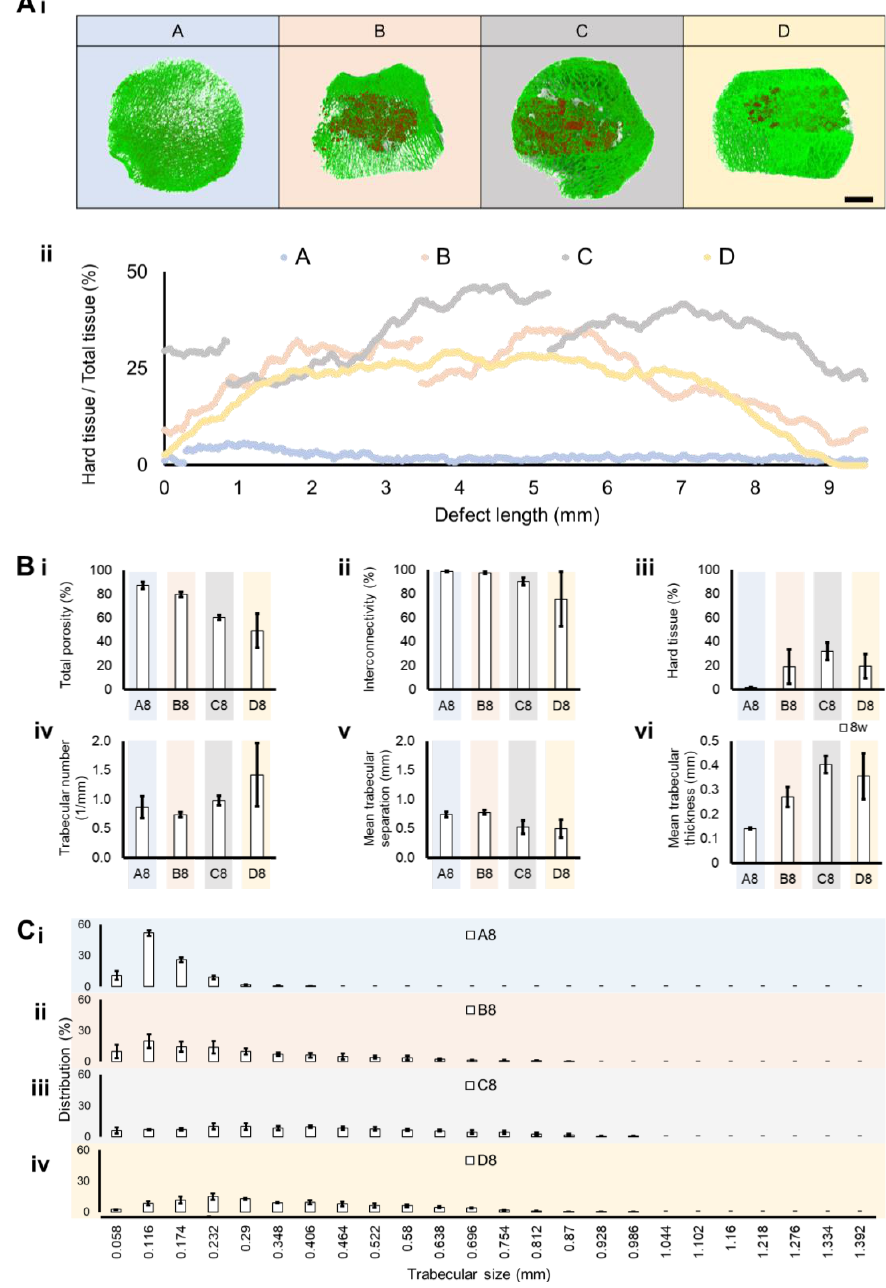
Figure 5. Micro-CT analysis of the implant in the distal femoral metaphysis section and control groups. ( A ) Three-dimensional reconstructions were performed and quantitatively analyzed for each group 8 weeks after surgical intervention. ( i ) Green (threshold of 30:100) and red (threshold of 100:255) represent softer material (equivalent to host tissue) and harder implanted structures, re- spectively (scale bar = 4 mm). ( ii ) The hard tissue (implant) distribution profile was traced per group, with its percentage represented along a bi-dimensional axis of 9.5 mm. ( B ) A total of 6 morphometric parameters were quantified from the analyzed regions per group after 8 weeks. ( i ) Total porosity, ( ii ) interconnectivity, ( iii ) hard tissue (representing the amount of implant remaining), ( iv ) trabecu- lar number per millimeter, ( v ) mean trabecular separation (meaning the pore size in between